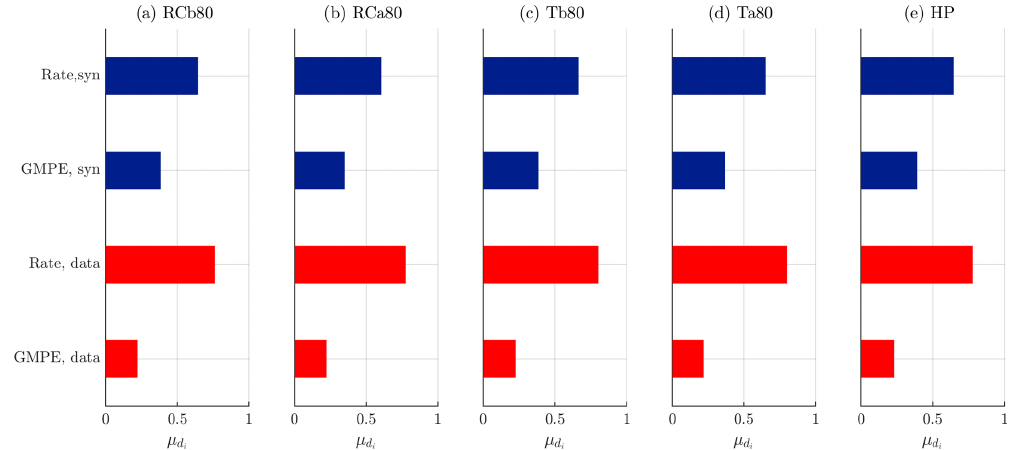
Figure 11. Sensitivity analysis of DR (observe that the QoI is logDR) based on the sensitivity measure µ d